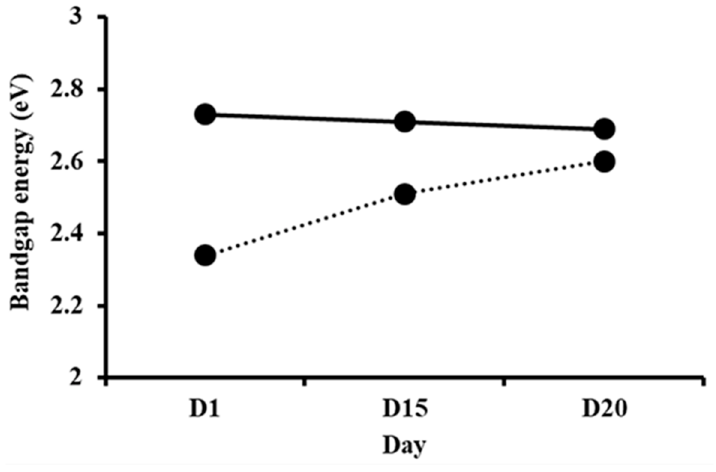
Figure 7. Band gap values of I ‐ AMP ( ⸻ ) and N ‐ AMP ( ∙∙∙∙∙ ) at D1, D15 and D20.